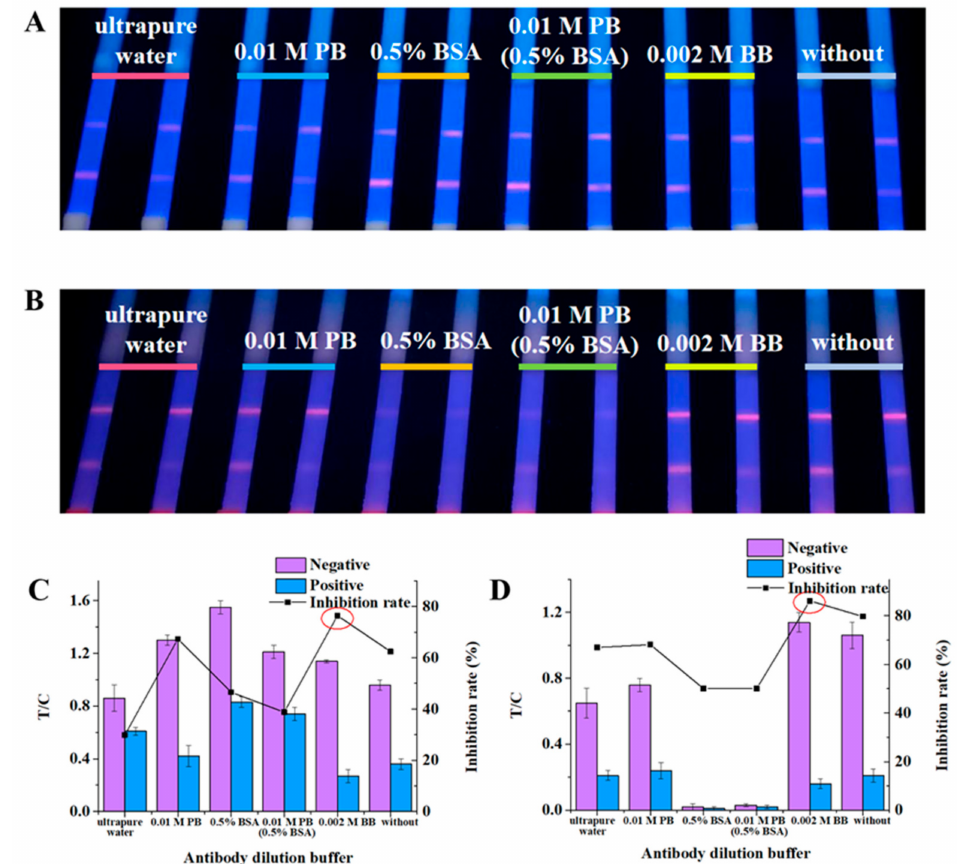
Figure 2. The fluorescence intensity, inhibition effect, and inhibition rate results of the Ab dilution buffer: ( A ) ultraviolet lamp results for milk detection; ( B ) ultraviolet lamp results for pork detection; ( C ) fluorescence quantitative results for milk detection; and ( D ) fluorescence quantitative results for pork